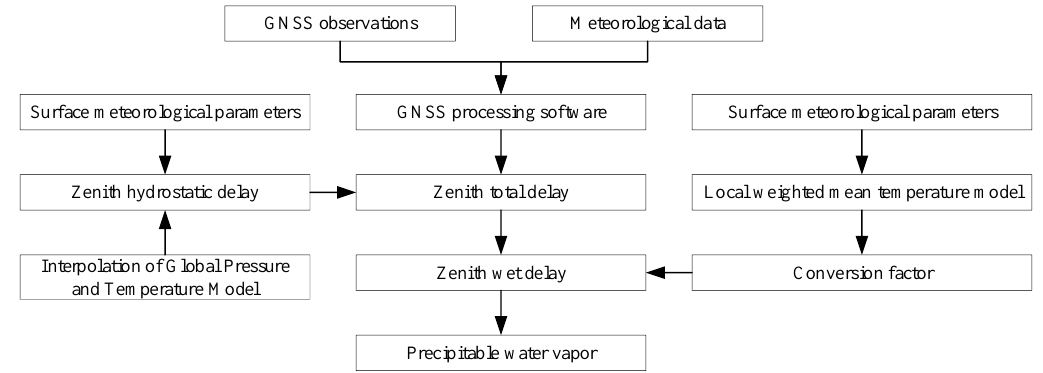
Figure 2. Flow chart for obtaining GNSS-derived PWV.